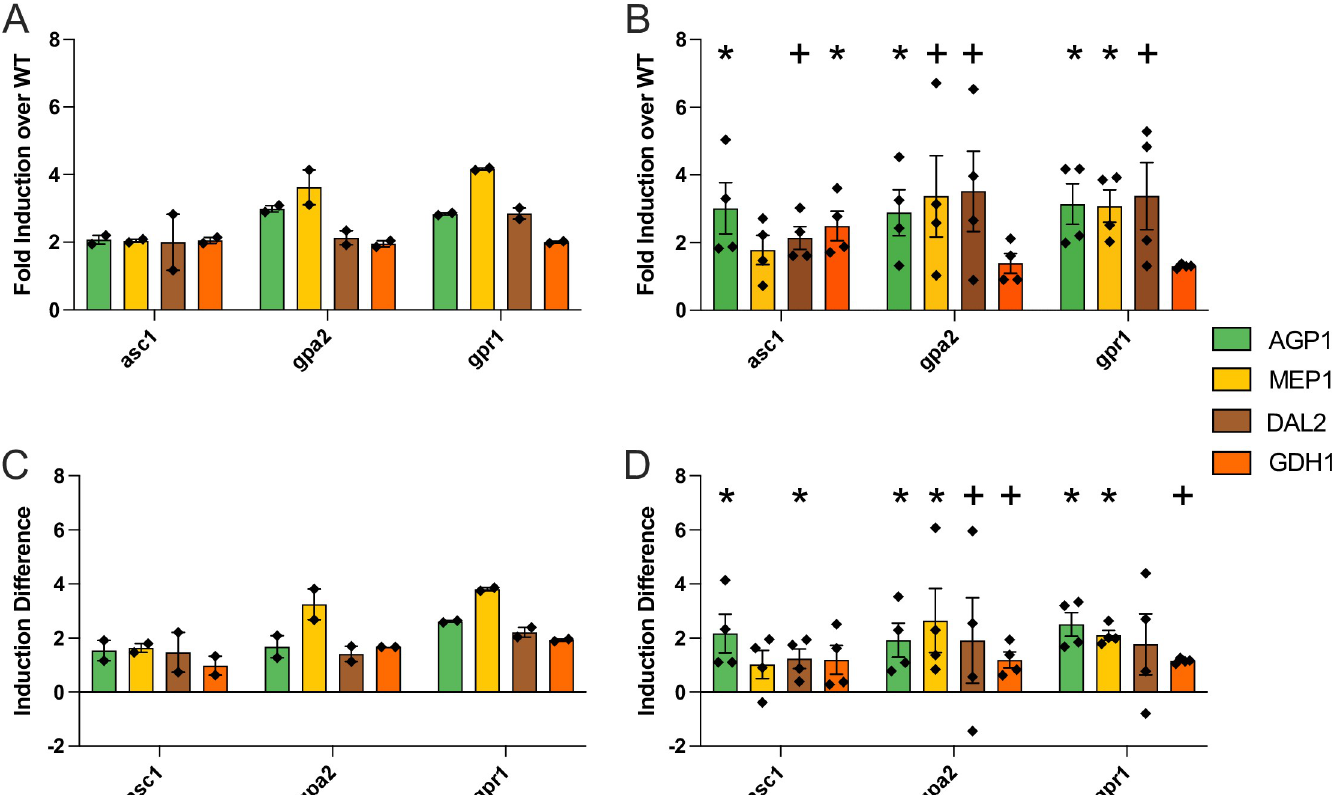
Fig 7. qPCR and RNA-seq analysis. A, B) Bar plots of concentration analysis results of A) RNA-seq data and B) qPCR data for AGP1 (green), MEP1 (yellow), DAL2 (brown) and GDH1 (orange). X-axes show mutants; Y-axes show fold induction over wildtype. C, D) Bar plots of sensitivity analysis results of C) RNA-seq data and D) qPCR data for AGP1 (green), MEP1 (yellow), DAL2 (brown) and GDH1 (orange). X-axes show mutants; Y-axes show change in induction between low and high glucose treatment. Error bars, standard error of the mean of biological replicates. Significance marks for qPCR analysis are as follows: p < 0.05( � ), p < 0.15(+) by Mann- Whitney U test and adjusted with the Benjamini-Hochberg